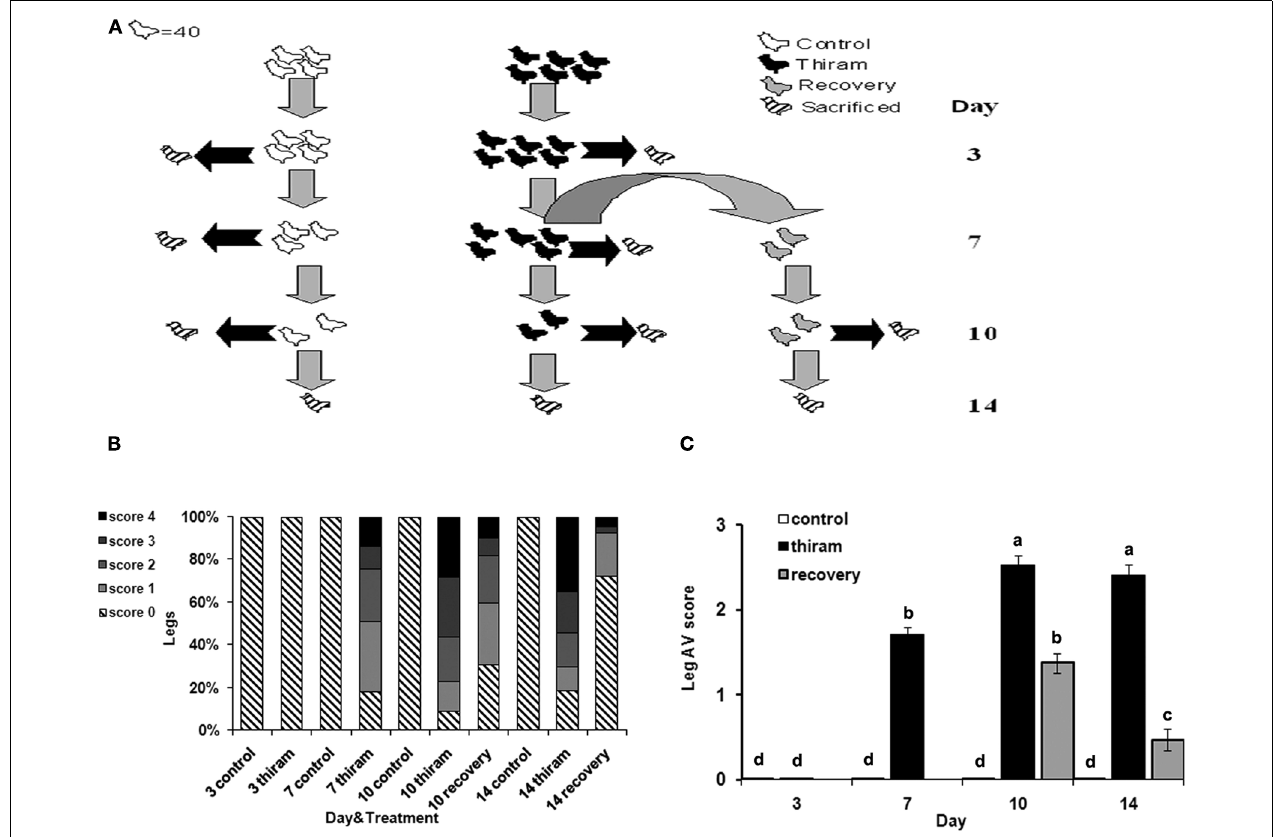
group were picked randomly and transferred to a non-thiram diet for further 7days (recovery). At days 3, 7, 10, and 14, 40 chicks from each group were scarified. All tibial growth plates were dissected and scored forTD severity. (B) Relative percentages of each score. (C) Average score for each